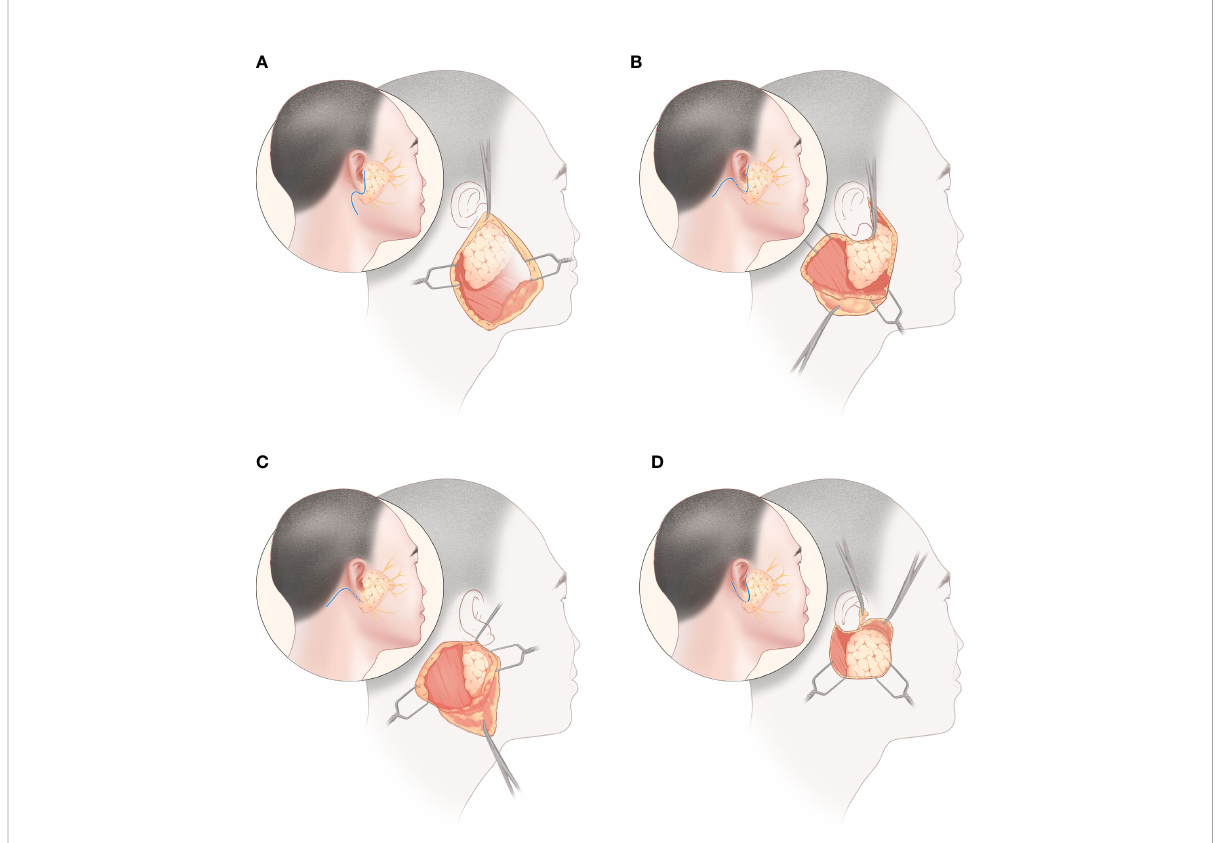
FIGURE 1 Parotidectomy via four incisions: (A) modi fi ed Blair incision, (B) modi fi ed facelift incision, (C) retroauricular hairline incision, (D) V-shaped